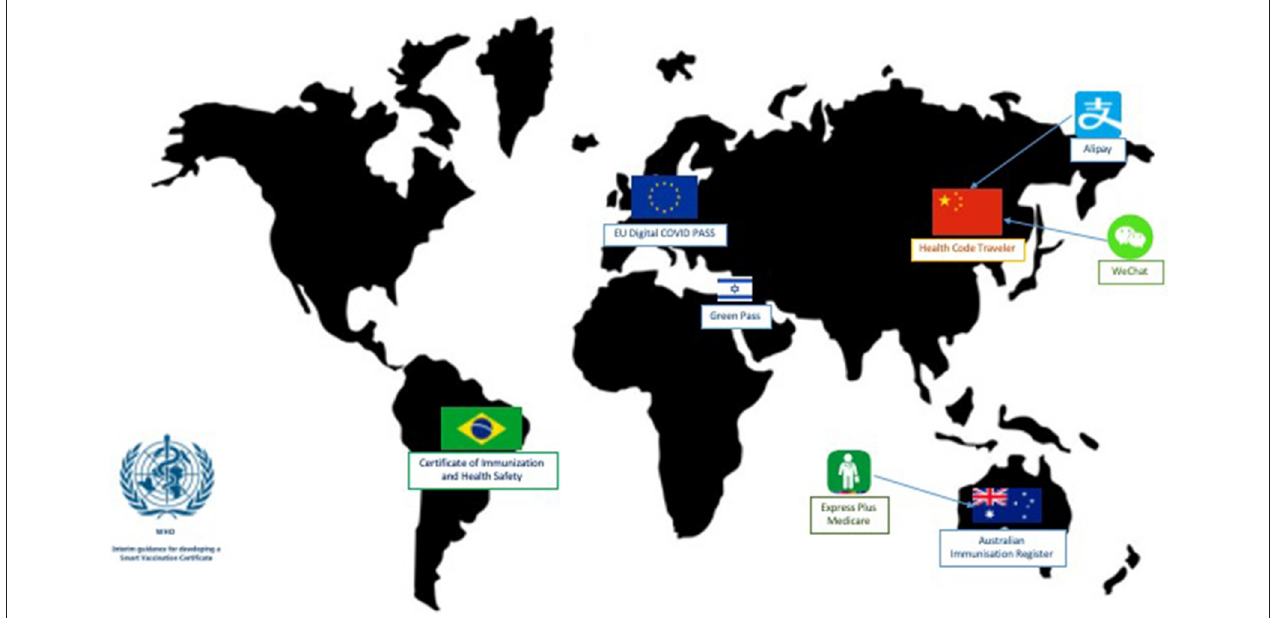
FIGURE 1 | Digital Covid-19 certificates initiatives currently available